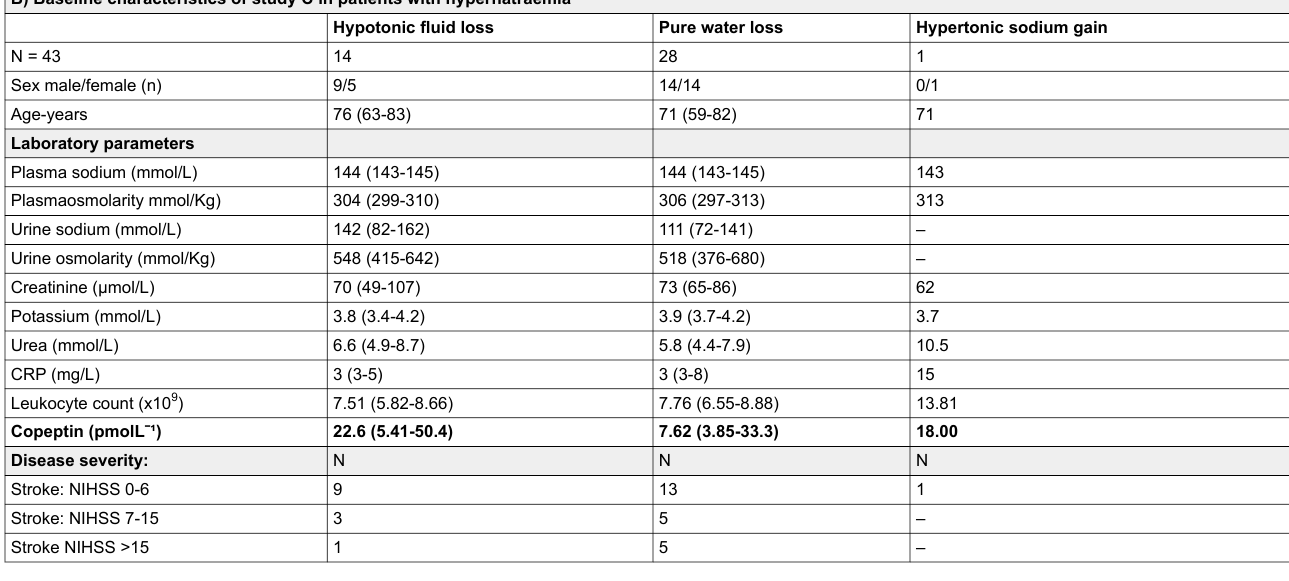
Table 3: Results from multivariate regression analysis combining the different studies A, B and C for the hyponatraemic population A) Multivariate regression analysis combining the three studies for different volaemic states